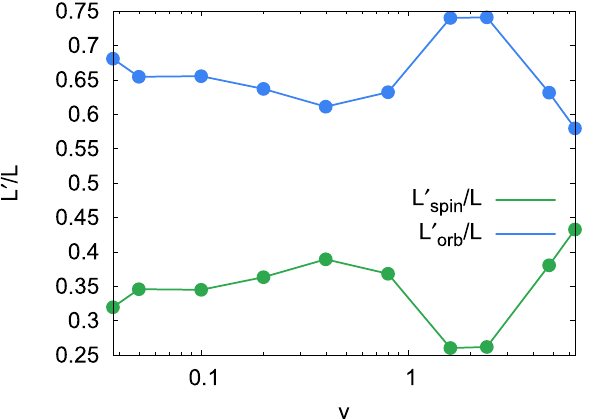
Figure 7. Relative spin and orbital momenta as a function of collision velocity v after collision with impact 0.5 . Note the logarithmic abscissa scale. parameter b =